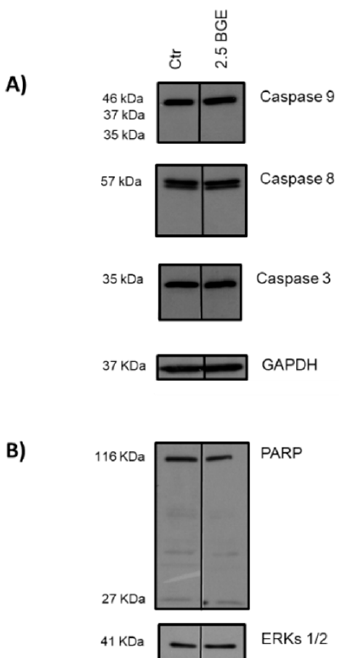
Figure 5. Black garlic methanol extract (BGE) did not restore the apoptotic program in U937 cells, as compared to untreated cells (Ctr). ( A ) Western blot of the indicated proteins after 2.5 mg/mL BGE treatment for 24 h on U937 cells. Glyceraldehyde 3-phosphate dehydrogenase (GAPDH) as loading control. ( B ) Western blot of the indicated protein after 2.5 mg/mL BGE treatment for 24 h on U937 cells. Extracellular signal-regulated protein kinases 1 and 2 (ERKs 1/2) as loading